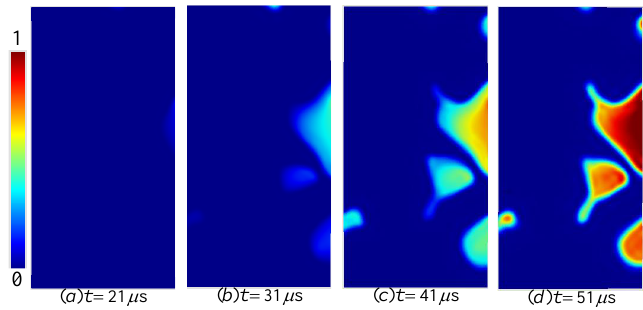
Figure 12. The evolution of damage field for the low amplitude load and cohesion realization with l c = 20 mm at times: ( a ) 21 µ s, ( b ) 31 µ s, ( c ) 41 µ s, and ( d ) 51 µ